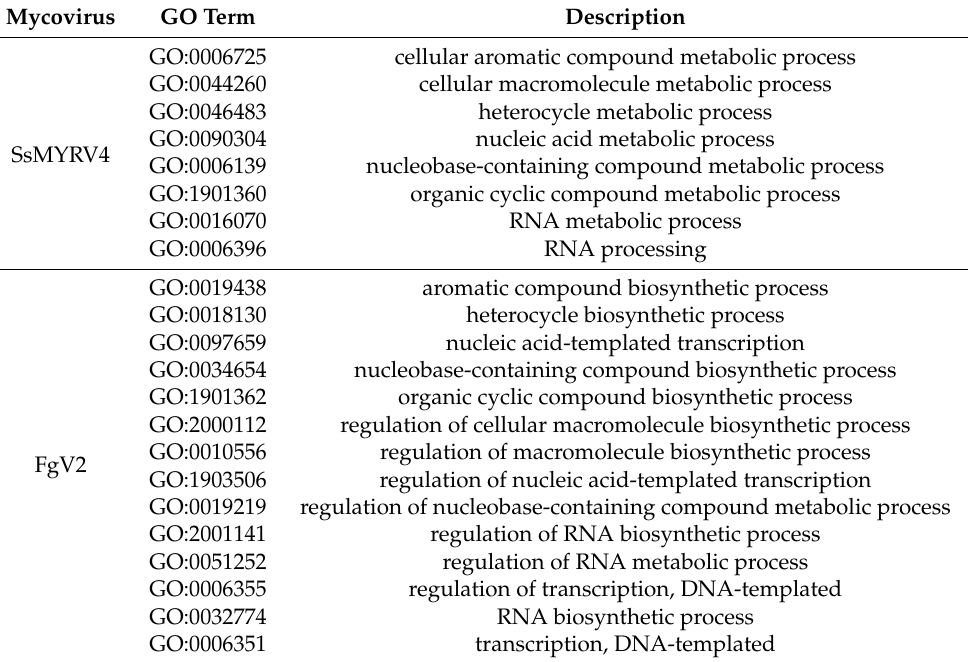
Table 1. The identical GO terms in the biological processes between host genes with similar codon usage to mycoviruses and the upregulated host genes upon mycoviruses